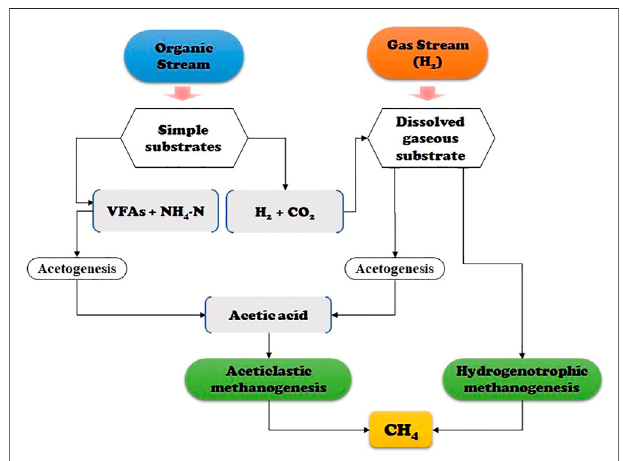
FIGURE 1 | Schematic diagram of the acetate-oxidizing bacteria assisted metabolic pathway via H 2 -substrate and hydrogenotrophic